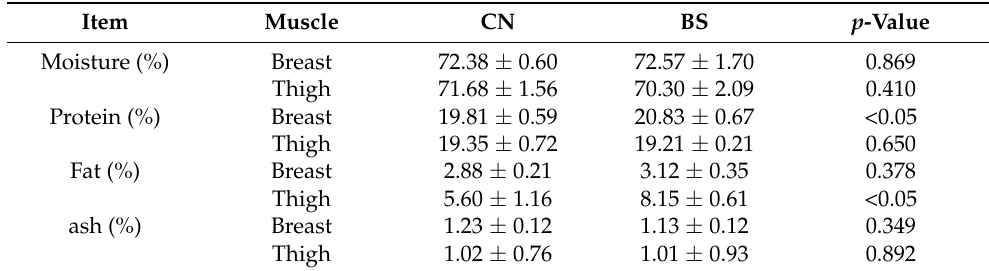
Table 5. Effects of dietary Brevibacillus laterosporus S62-9 on the chemical composition of chicken meat. Item